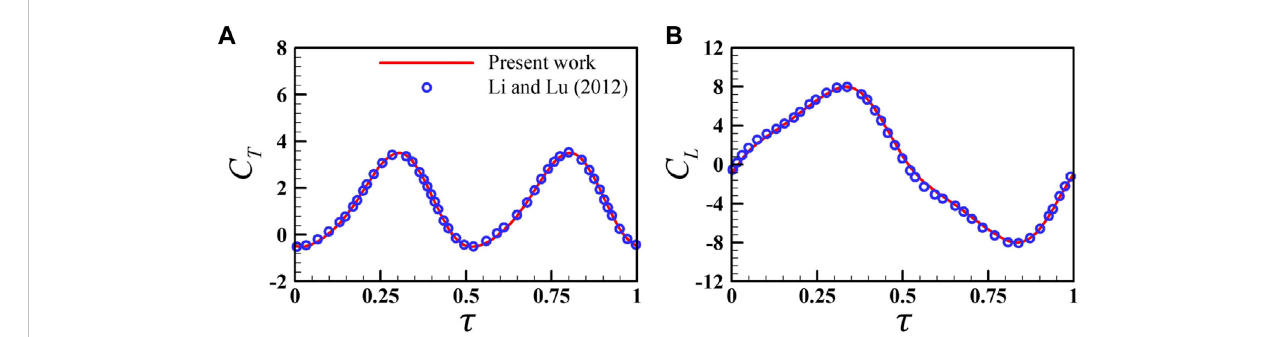
FIGURE 2 Comparison of the present instantaneous lift coef fi cient (A) and drag coef fi cient (B) with previous data obtained by Li and Lu [29] for a rectangular plate with an aspect ratio of 0.5 at Re (cid:1)